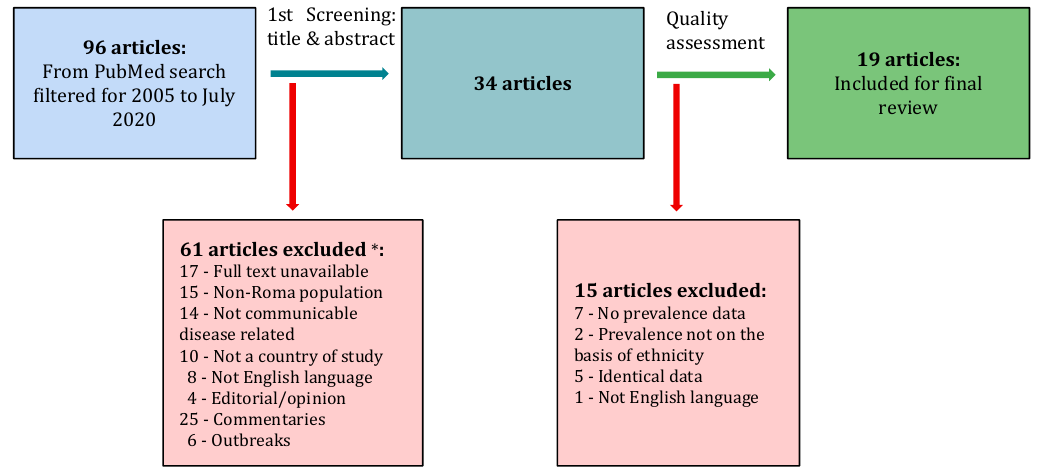
Figure 1. Flowchart showing steps for inclusion/exclusion. * Reasons for exclusions may overlap.